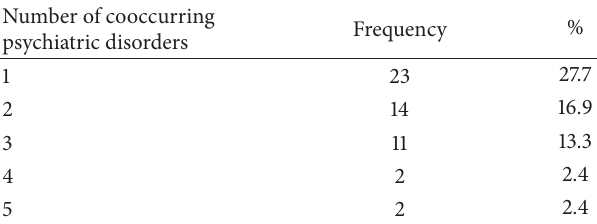
Table 2: Number of lifetime DSM Axis I psychiatric comorbidities in